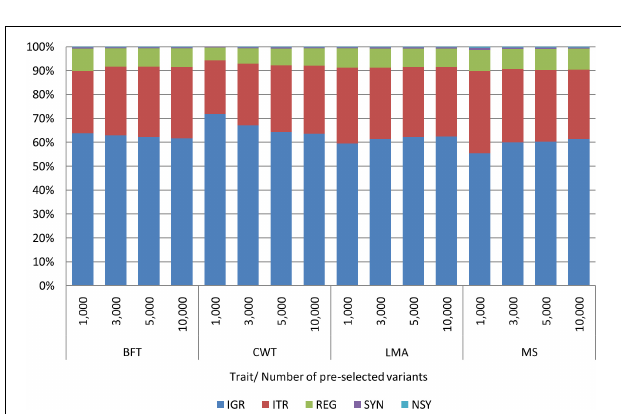
FIGURE 4 | Functional classification of 1,000, 3,000, 5,000, and 10,000 pre-selected variants from WGS by trait. Backfat thickness (BFT), carcass weight (CWT), longissimus muscle area (LMA), and marbling score (MS). Intergenic (IGR), intron (ITR), regulatory (REG), synonymous (SYN), and non-synonymous